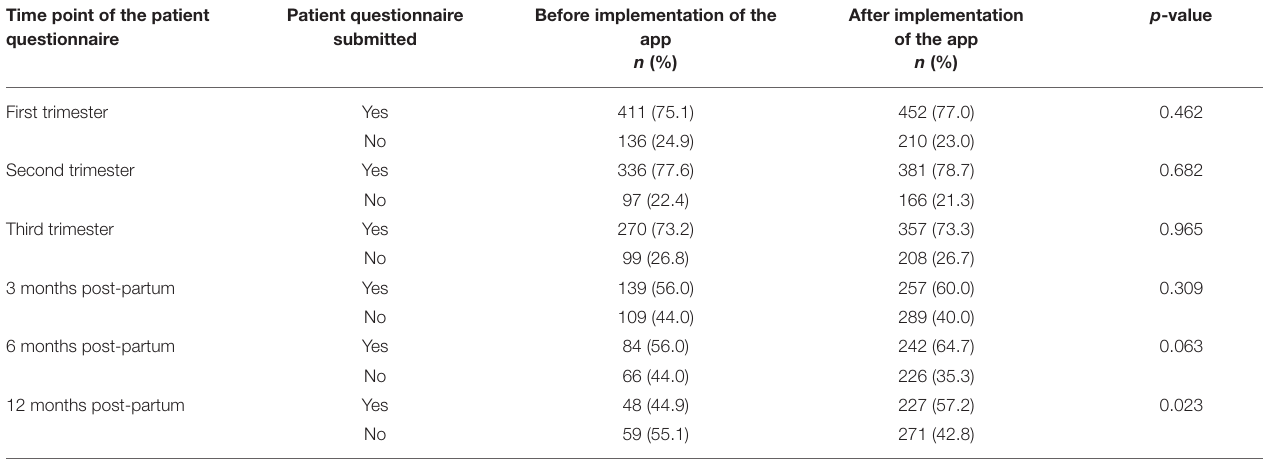
TABLE 2 | Proportion of patient reported forms received before and after the implementation of the Rhekiss-app (100% was assumed as the expected number of patient forms at the corresponding time point). Time point of the patient questionnaire